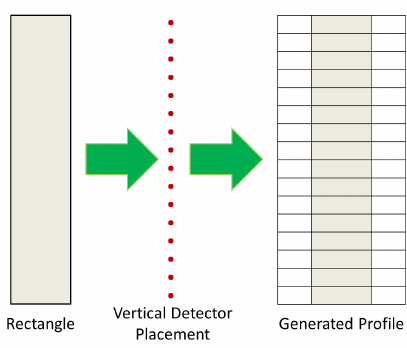
Figure 4. Vertically straight rectangle passing through vertical array N-IR profiling sensor.